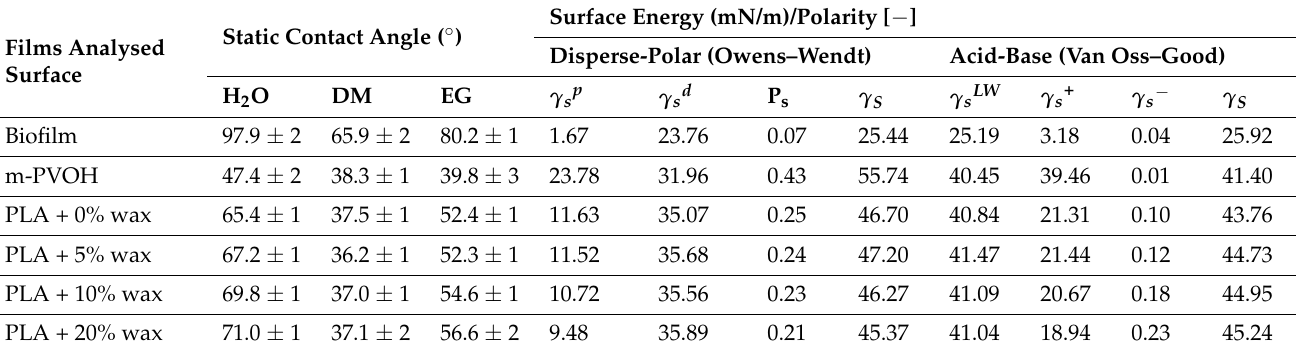
Table 6. Static/equilibrium contact angles for the different multilayers’ surfaces in water (H 2 O), diiodomethane (DM) and ethylene glycol (EG). Surface energies comprising polar and dispersive components and polarity following the Owens–Wendt approach; Lifshitz–van der Waals and acid– base components following the van Oss–Good approach.